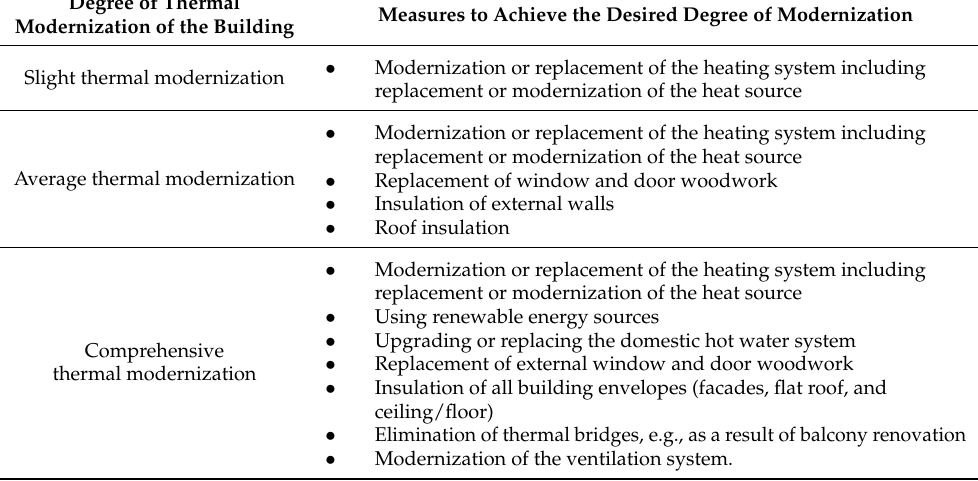
Table 2. Degrees of thermal modernization of the